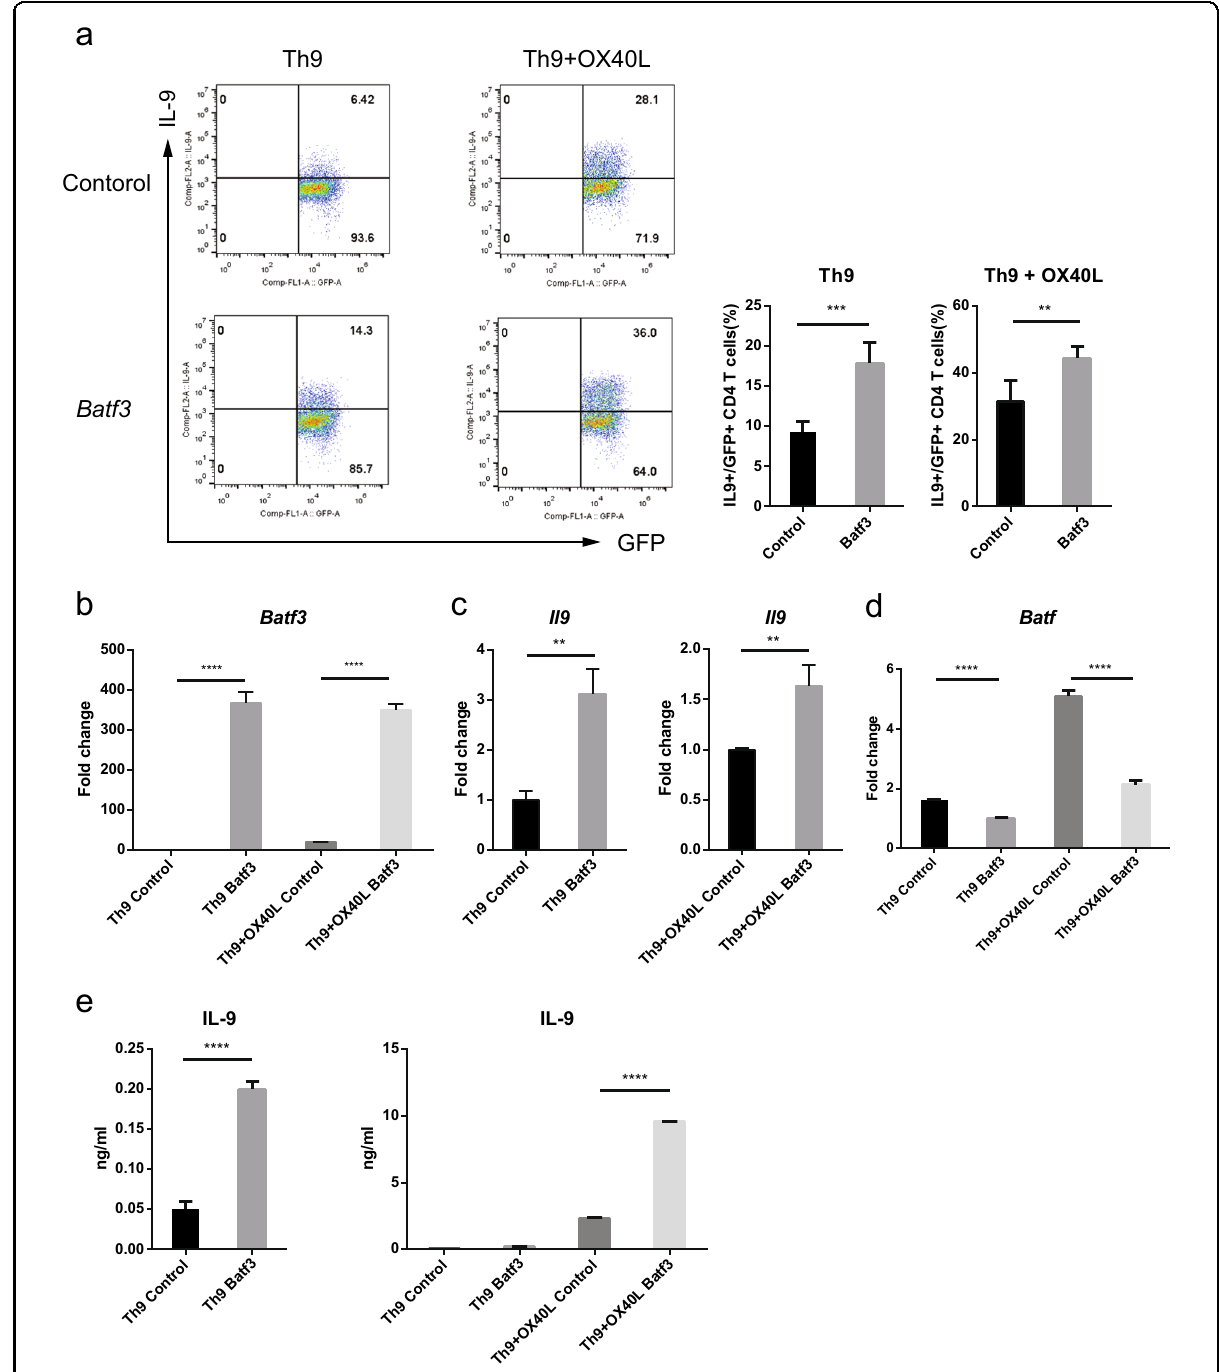
Fig. 2 Increased expression of IL-9 in Batf3- overexpressing Th9 cells. a CD4 + T cells were cultured under Th9 or Th9 + OX40L conditions. Transduced cells were gated for GFP and analyzed by fl ow cytometry. b , c Transduced cells were sorted using a fl ow cytometer, and RNA was isolated. The expression of Batf3 and Il9 mRNA under each condition was measured by qRT-PCR. Data were normalized to Gapdh levels and are shown relative to Th9 control or Th9 + OX40L control cells. d Expression of Batf mRNA was measured by qRT-PCR when Batf3 was overexpressed under each condition. e Cells were stimulated for 4 h with PMA and ionomycin. The concentration of IL-9 in the culture supernatant was measured by ELISA. Error bars represent the s.d. P value were calculated using Student ’ s t -tests. * P < 0.05, ** P < 0.01, and *** P < 0.001. All experiments were repeated independently three or four